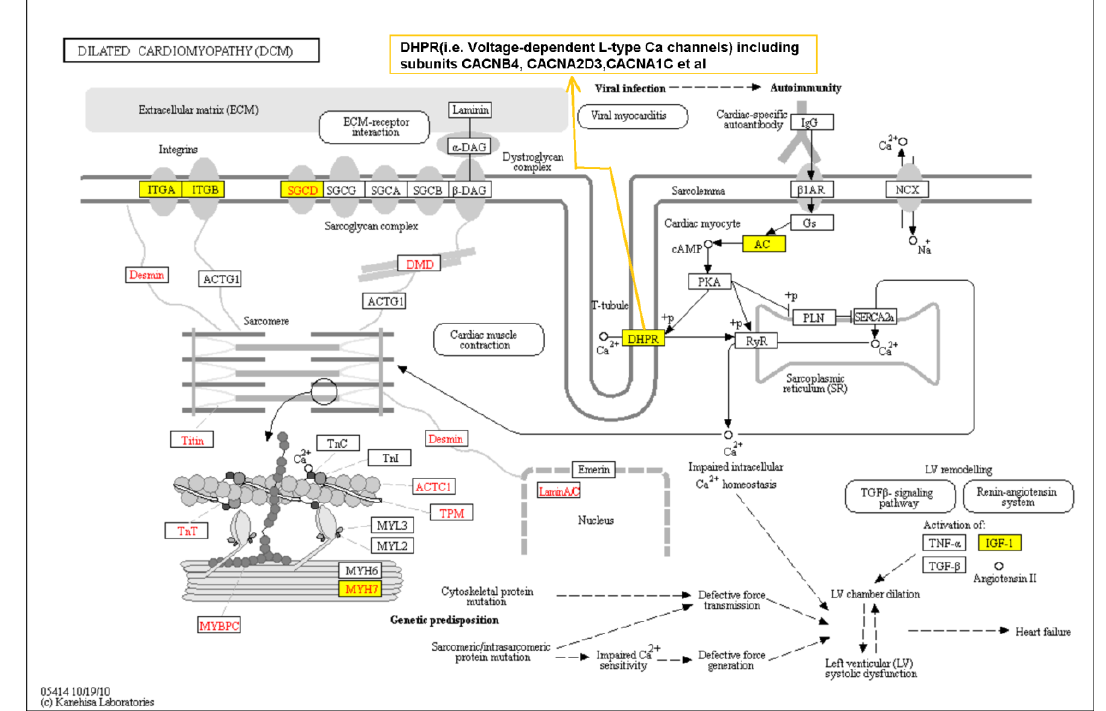
Figure 2. Kyoto Encyclopedia of Genes and Genomes (KEGG) dilated cardiomyopathy pathway overlaid with the top 1000 genes (in yellow box) indicated in our current genome wide association study of idiopathic dilated cardiomyopathy (IDC) in African Americans. Genes with mutations that have been reported in IDC are colored in red font.